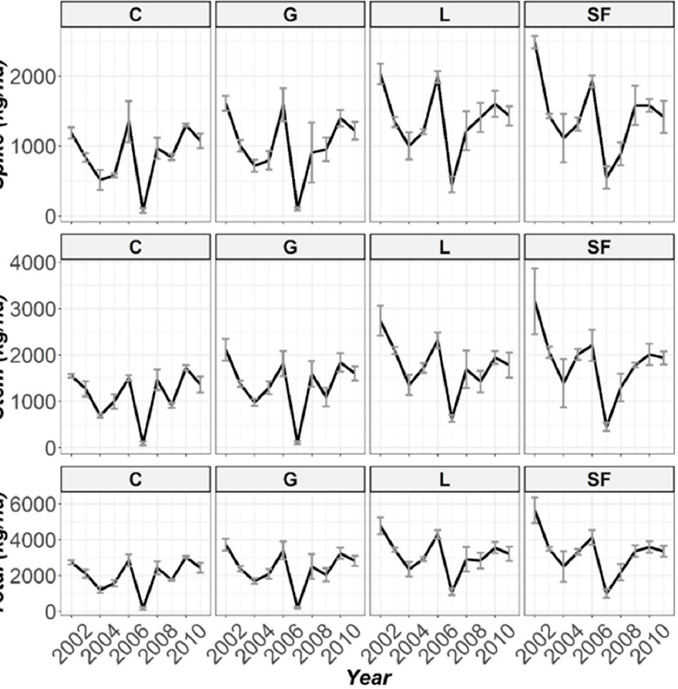
Figure 6. Temporal evolution of spike, stem and total biomass throughout the ten years of biomass monitoring (2002–2011).